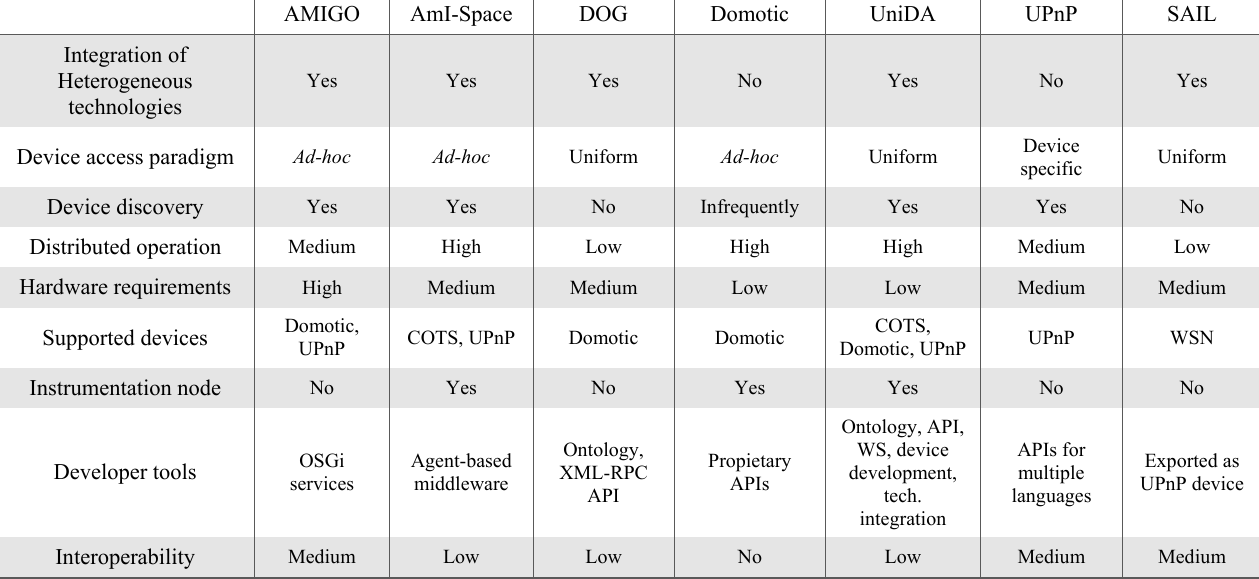
Table 1. Comparison table of instrumentation technologies for